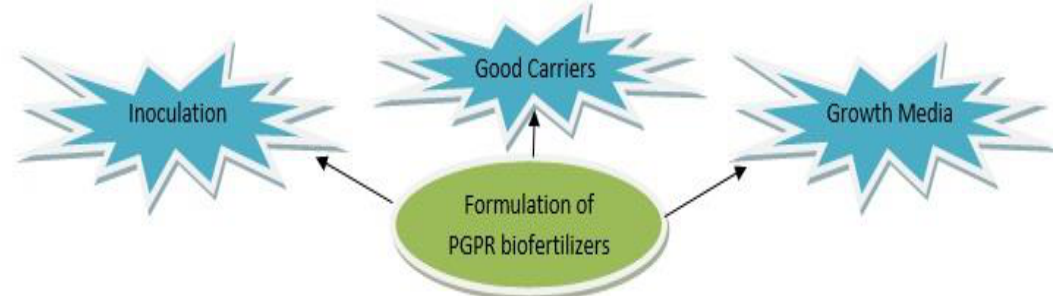
Fig. 3: Formulations of PGPR Bio-fertilizers